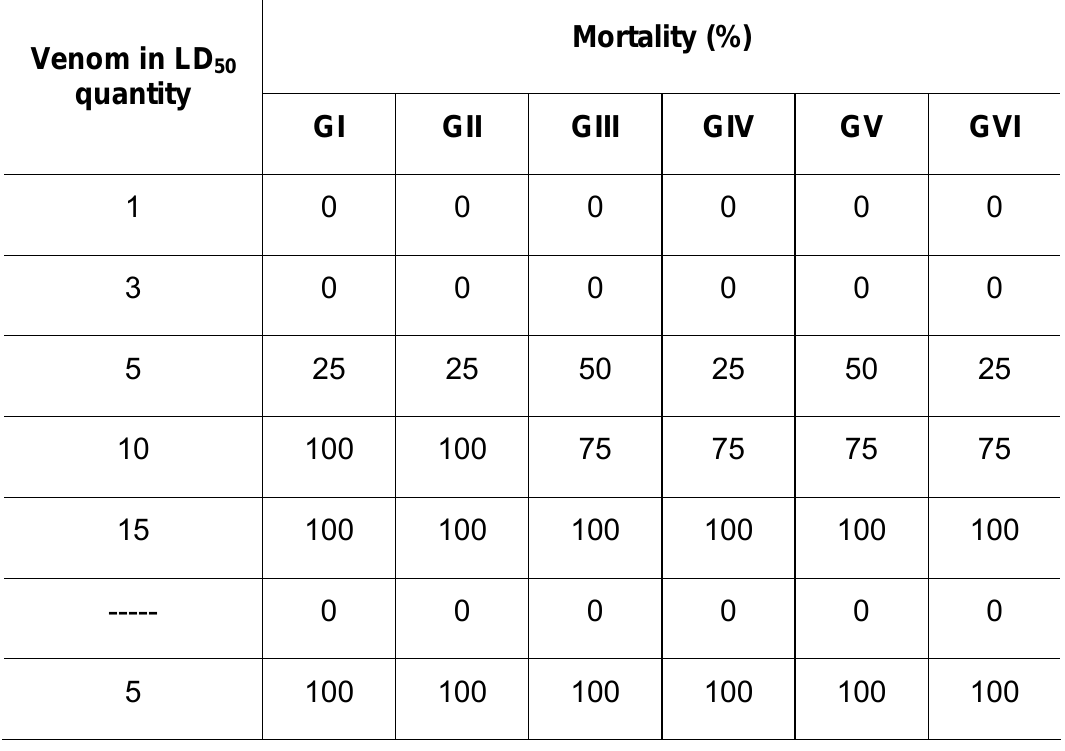
Table 1: Determination of the potency of Bothrops jararaca , native (GI) and irradiated (GII) , Bothrops jararacussu , native (GIII) and irradiated (GIV), and Bothrops moojeni , native (GV) and irradiated (GVI) antivenoms prepared with native or irradiated venoms.